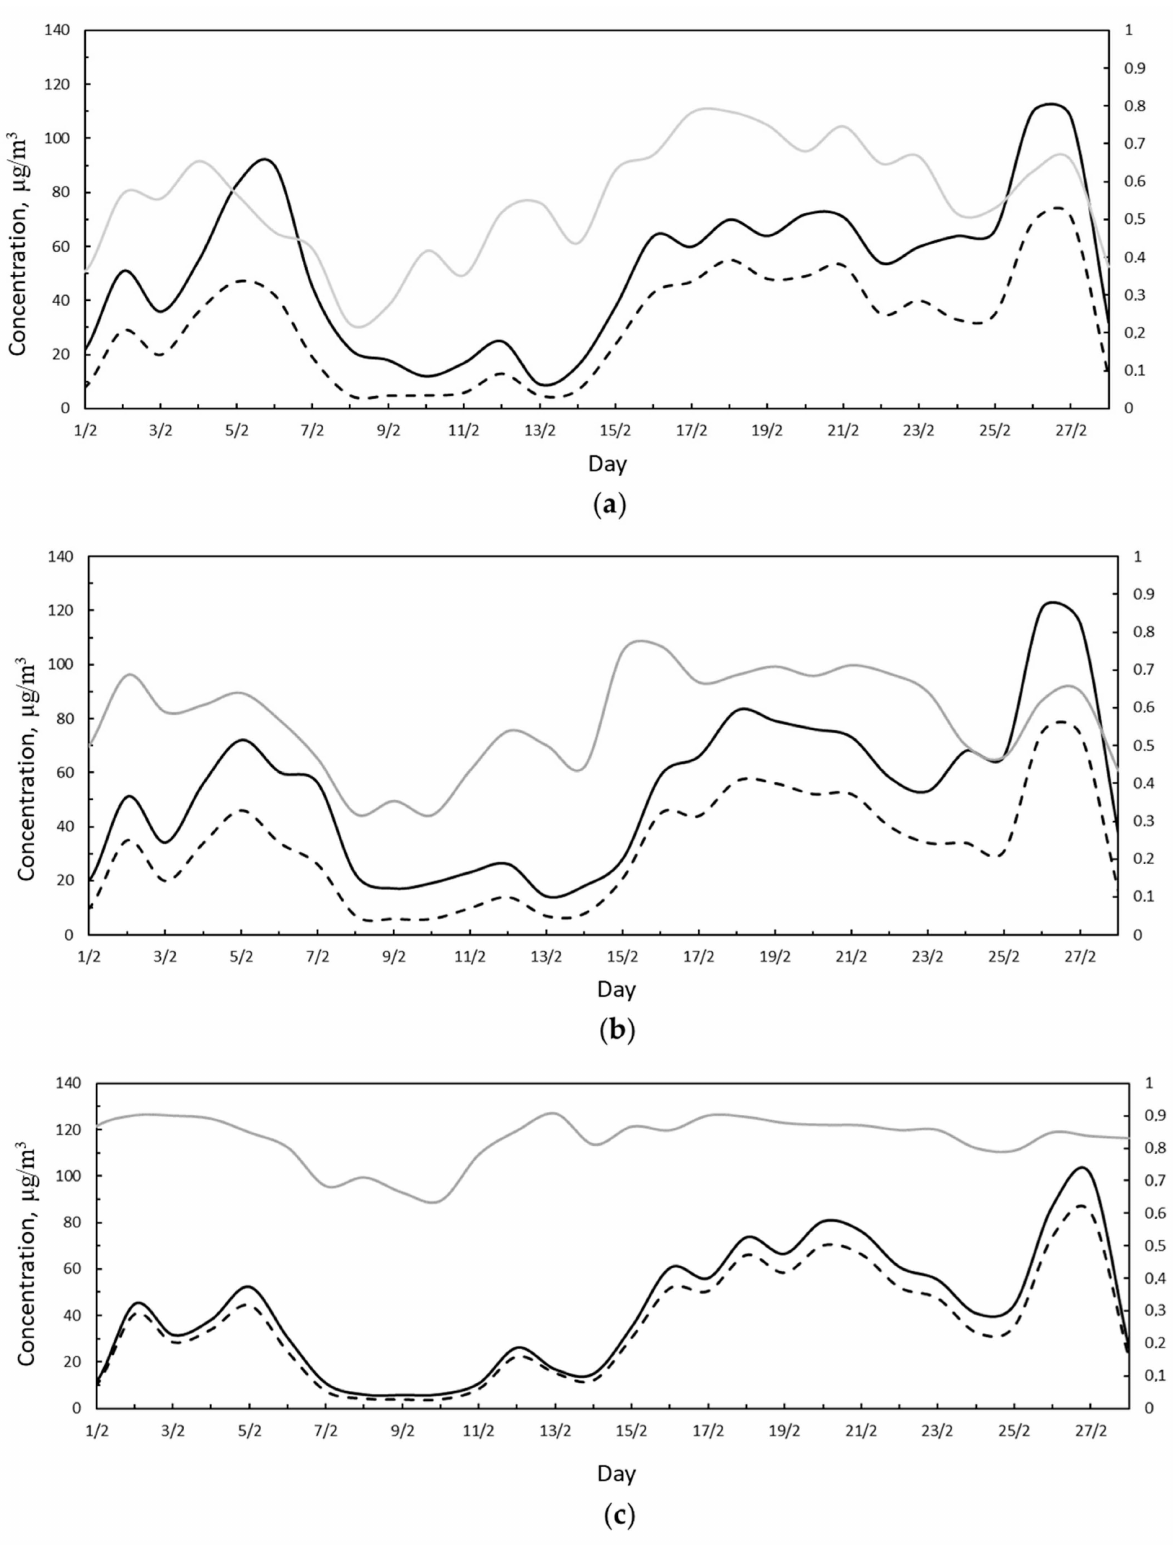
Figure 6. ( a ) Daily PM10 (black solid line), PM2.5 (black dashed line), and PM2.5/PM10 concentrations (grey solid line) measured during February 2021 at the SA station. ( b ) Daily PM10 (black solid line), PM2.5 (black dashed line), and PM2.5/PM10 concentrations (grey solid line) measured during February 2021 at the VC station. ( c ) Daily PM10 (black solid line), PM2.5 (black dashed line), and PM2.5/PM10 concentrations (grey solid line) measured during February 2021 at the MV